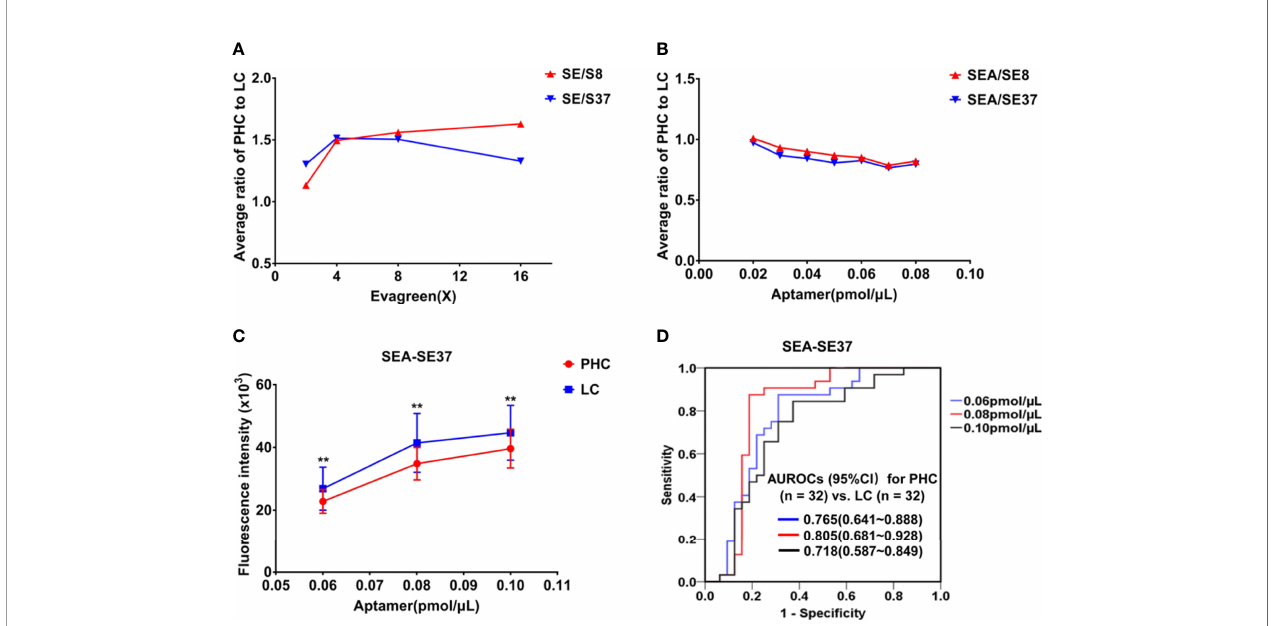
FIGURE 3 | Optimization of measurement conditions for aptamer-based triple serum fl uorescence intensities. (A) The fl uorescence indicator ratios of PHC to LC in a series of EvaGreen concentrations in pooled sera (n = 3). (B) Fluorescence indicator ratios of PHC to LC at a series of aptamer AP-HCS-9-90 concentrations and 8× EvaGreen in pooled sera (n = 3). (C) The fl uorescence indicator SEA-SE37 of serum specimens (n = 32, PHC and LC each) at various aptamer AP-HCS-9-90 concentrations and 8× EvaGreen. **P < 0.01. (D) Receiver operator characteristic curves of SEA-SE37 for the diagnosis of PHC at various aptamer AP-HCS-9-90 concentrations. Abbreviations in the fl uorescence indicators: S, serum; E, EvaGreen; A, aptamer; 8, 8°C; 37, 37°C; SE/S8 or SE/S37: the fl uorescence intensity ratio of serum reacted with EvaGreen to original serum at 8°C or 37°C; SEA-SE8 or SEA-SE37, the fl uorescence intensity difference of serum incubated with 8× EvaGreen and aptamer and serum reacted with 8× EvaGreen at 8°C or 37°C. PHC, primary hepatic carcinoma; LC, liver cirrhosis; AUROC, area under the receiver operator characteristic curve; CI, con fi dence interval.